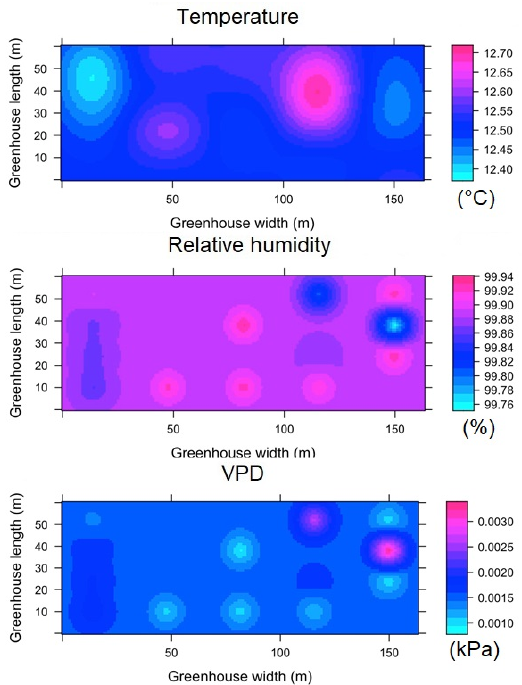
Figure 13. Spatial distribution predicted by kriging, for temperature, relative humidity and VPD in HGT1 and for ESRL 1.